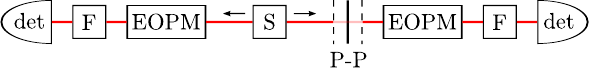
Figure 1: Experimental setup for generating frequency-entangled photons (source S) and measuring two-photon interference in the frequency domain (electro-optic phase modulators EOPMs, fre- quency filters F, single-photon detectors det) after a photon has been subject to a photon–plasmon–photon conversion (P-P). See text for a detailed